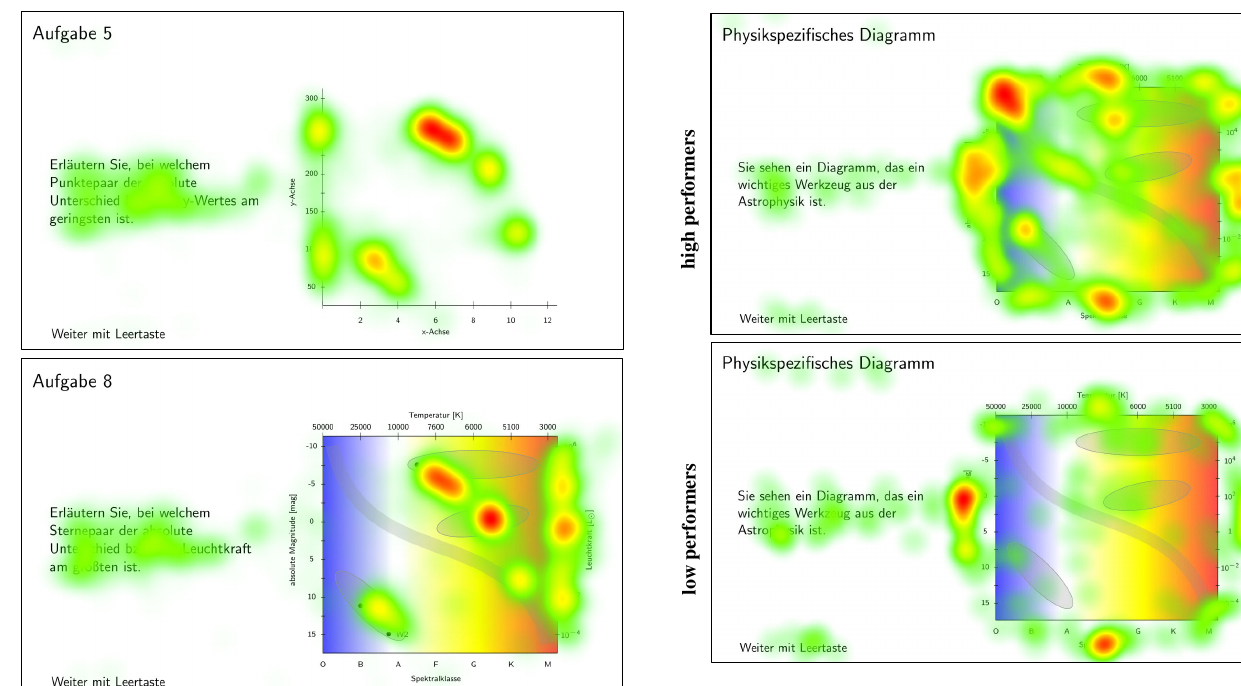
FIG. 10. Heat maps of all high performers (top) and all low performers (bottom) in comparison. The heat maps refer to the stimuli as originally used in the study (English translations can be found in the Supplemental Material [51]) where students were learningabouttheHRDforthefirsttime(without problem